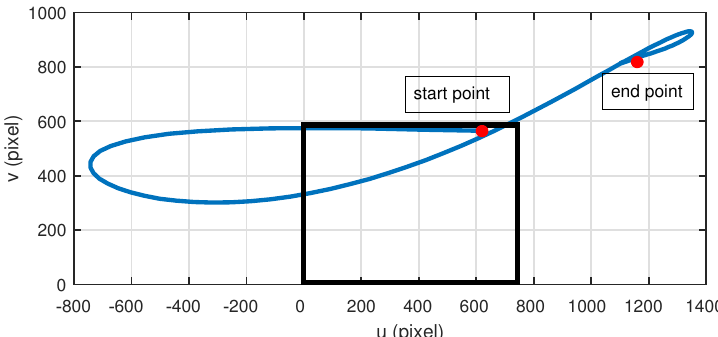
Figure 5. The projection trajectory on the image plane for the position-based controller.